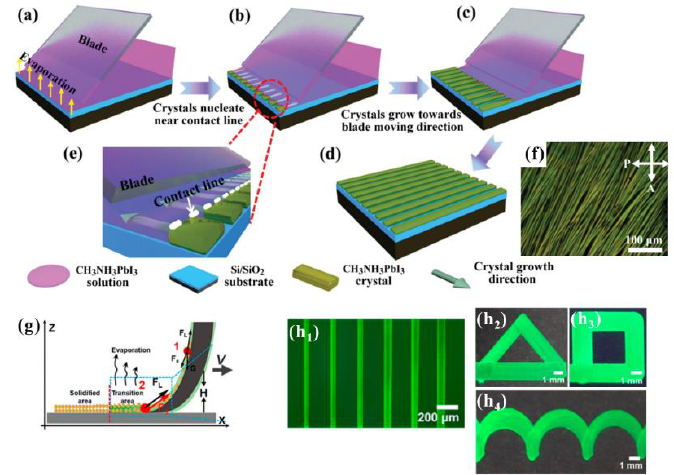
Figure 2. Schemes of one-step blade coating methods ( a ) the perovskite solution is dragged with a blade to form a triple-phase contact line. ( b ) The crystal nucleates close to the contact line. ( c ) Along the movement of the blade, the nuclei develop into crystals. ( d ) The CH 3 NH 3 PbI 3 arrays are created parallel to the moving direction of the upper blade. ( e ) Enlarge image of ( b ). ( f ) Cross-polarized optical image of the scheme ( d ). Reproduced with permission [45]. Copyright 2020. Wiley-VCH. ( g ) Fine-tuned conical fibers, called “Chinese brush” , transfer QD solutions onto the substrate. (h) Various QD patterns drawn by the Chinese brush are shown: 40 µm-width line arrays ( h 1 ), a triangle ( h 2 ), a square ( h 3 ), and a wave ( h 4 ). Reproduced with permission [44]. Copyright 2018, American Chemical Society.